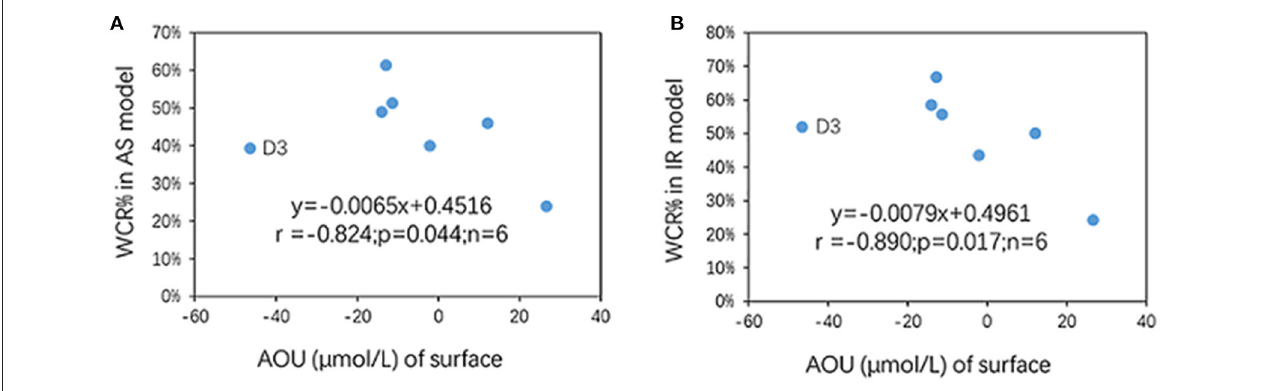
FIGURE 10 | The WCR% contribution to the total AOU of the near-bottom waters and its relationship with AOU of the surface waters: (A) AS model and (B) IR model. Note that only near-bottom water samples are shown; r, p, n in the plot were derived without data from D3.